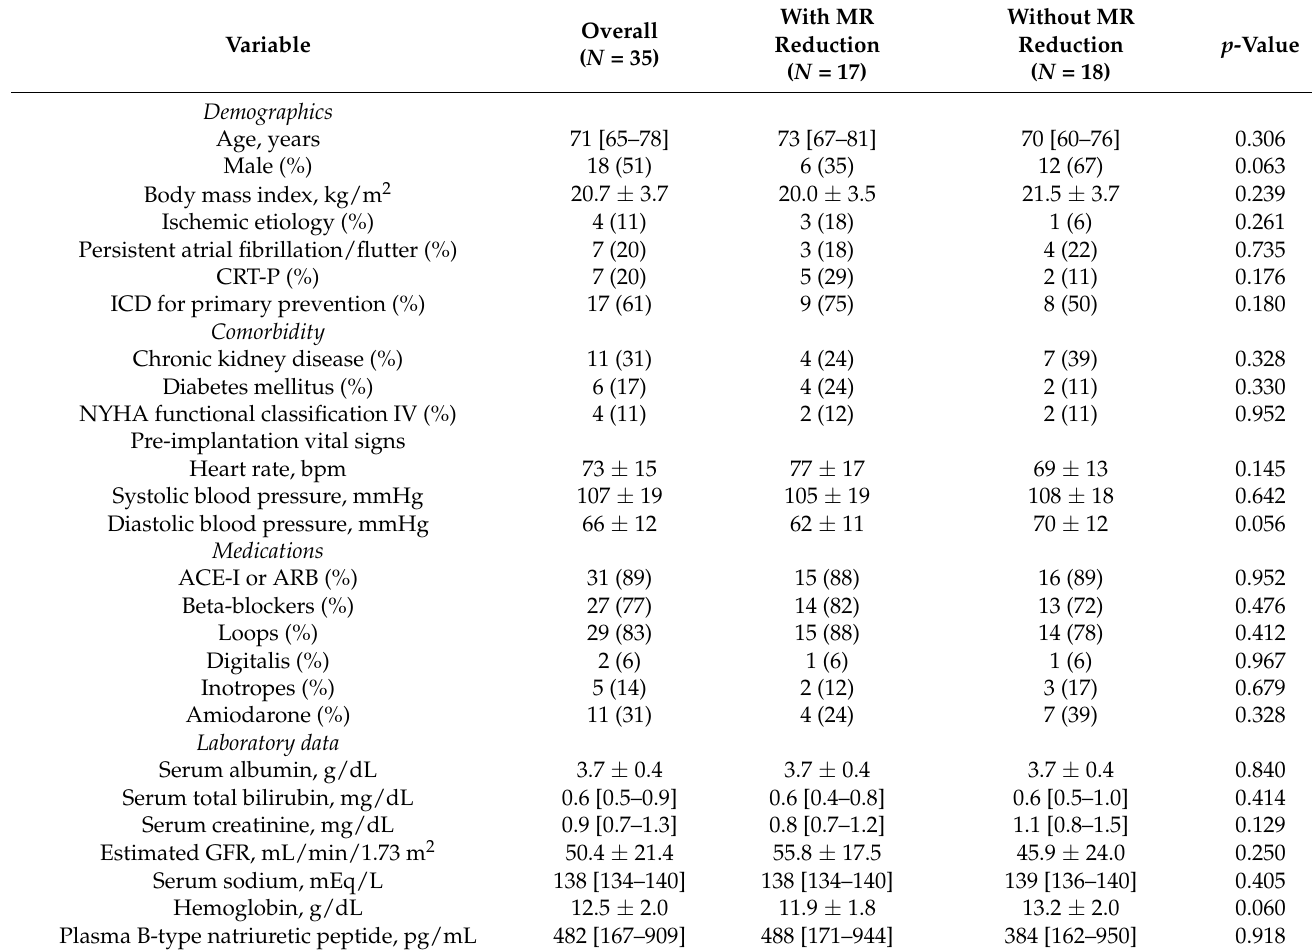
Table 1. Comparison of characteristics in patients with and without MR